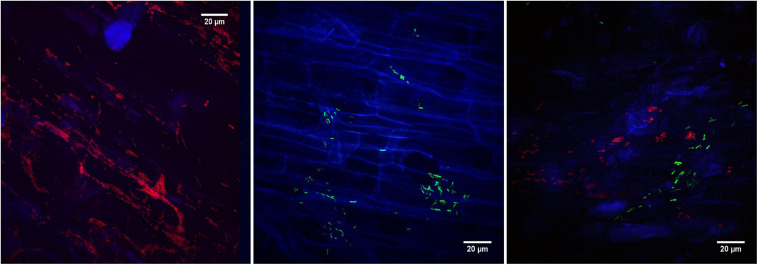
Confocal fluorescence microscopy images of L. corniculatus roots inoculated with the glyphosate degrading microorganisms. On the left, O. haematophilum P6BS-III m-Cherry + close to the tip of the main root. On the middle, R. sp. P44RR-XXIV GFP+. On the right, L. corniculatus roots were inoculated with O. sp. P6BS III mCherry+ and R. sp. P44RR-XXIV GFP+, where different locations in the root can be observed for each microorganism.